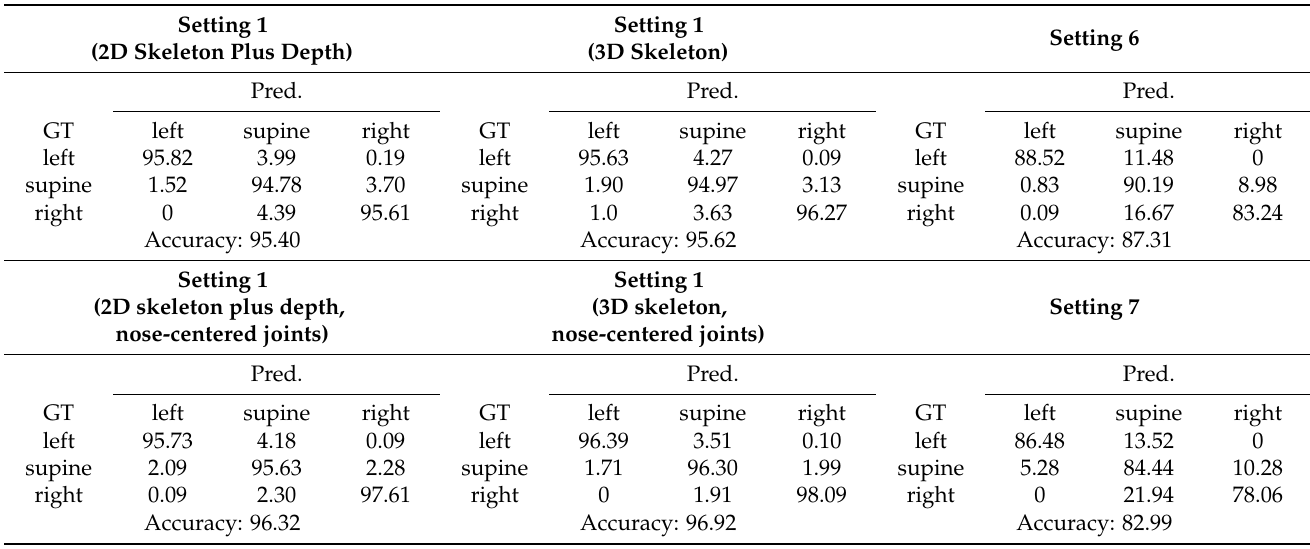
Table 4. Accuracy and confusion matrix (all numbers in terms of %) for different